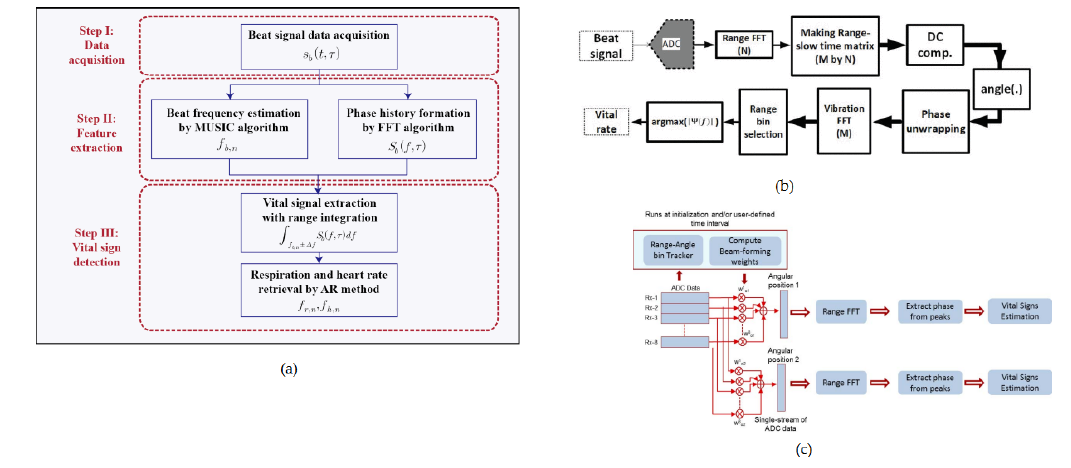
Figure 13. Algorithms used in ( a ) [138], ( b ) [140] and ( c ) [141] to retrieve the range and vital signs of subjects-under-test (SUTs).